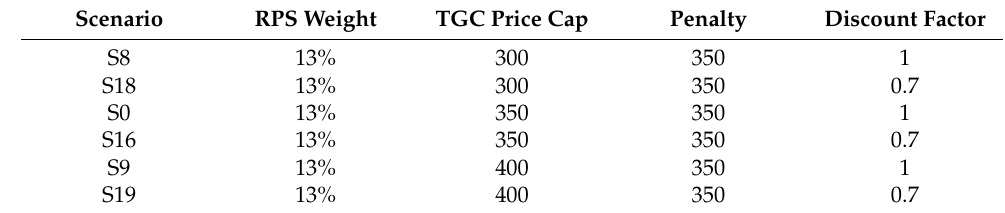
Table 6. Scenarios for analyzing impacts of discount factors under different TGC price caps.